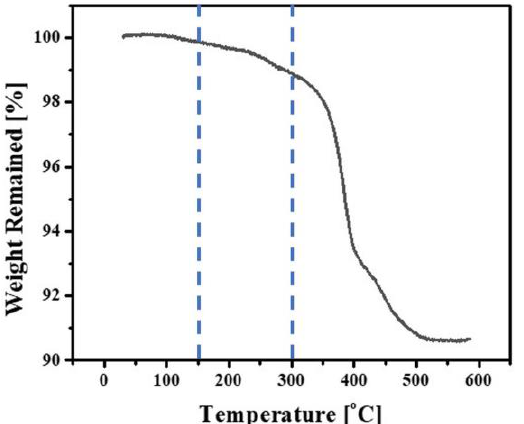
Figure 3. TGA curve observed for an as-printed 5Y-PSZ sample as a function of temperature. The dotted lines at 150 ◦ C and 300 ◦ C represent starting temperatures for thermal decomposition of organic phases and photopolymerized HDDA, respectively.